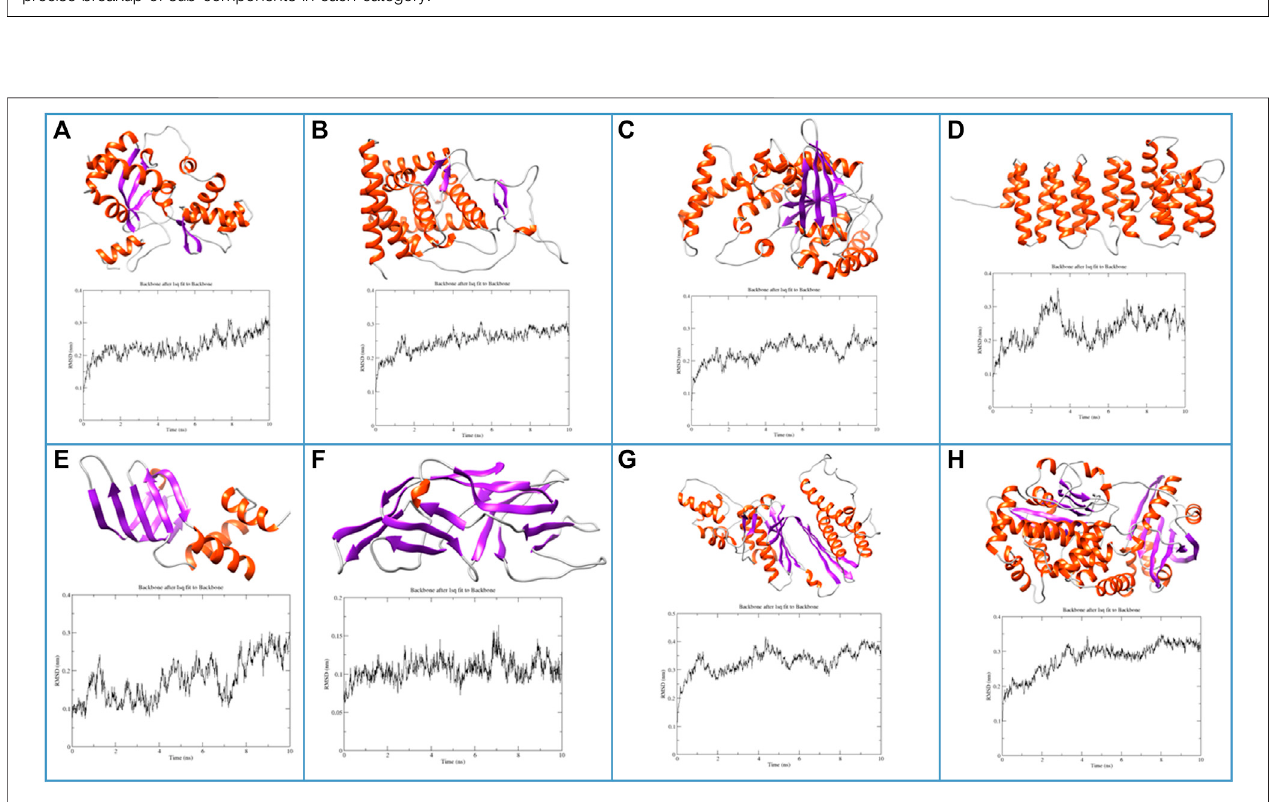
FIGURE3| MolecularstructuresandMDtrajectoryRMSDgraphsoftheshortlistedproteins (A) PF3D7_1368300, (B) PF3D7_1204500, (C) PF3D7_1308500, (D) PF3D7_1438600, (E) PF3D7_0418400, (F) PF3D7_1351100, (G) PF3D7_1442800 and (H) PF3D7_1402000.